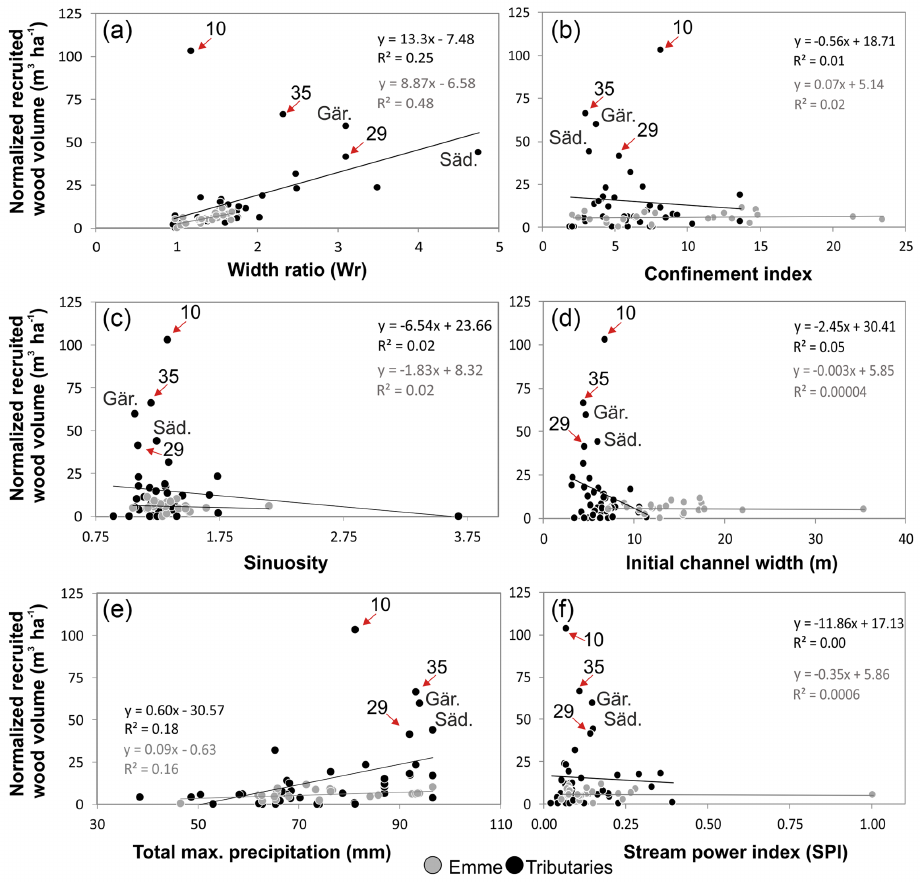
Figure 7. Relationships between recruited wood volume normalized by stream hectare (m 3 ha − 1 ; mean value according to mean value of forest density) and (a) width ratio; (b) confinement index; (c) sinuosity; (d) initial channel width (m); (e) total maximum precipitation (mm); (f) SPI. Grey and black lines show regression lines for the Emme River and tributary sub-reaches, respectively. Säd.: Sädelgrabe; Gär.: Gärtelbach; numbers correspond to sub-reaches as shown in Table